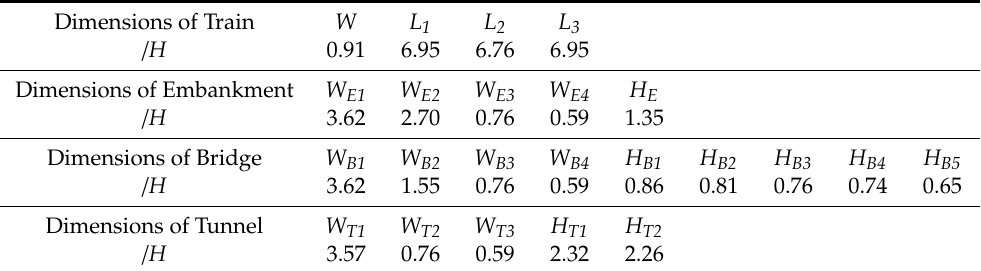
Figure 2. Models used in the calculation: ( a ) The CRH2 (China Railway High-speed 2) train; ( b ) cross-sections of the embankment, bridge, and tunnel. Table 1. Dimensions of geometric models.